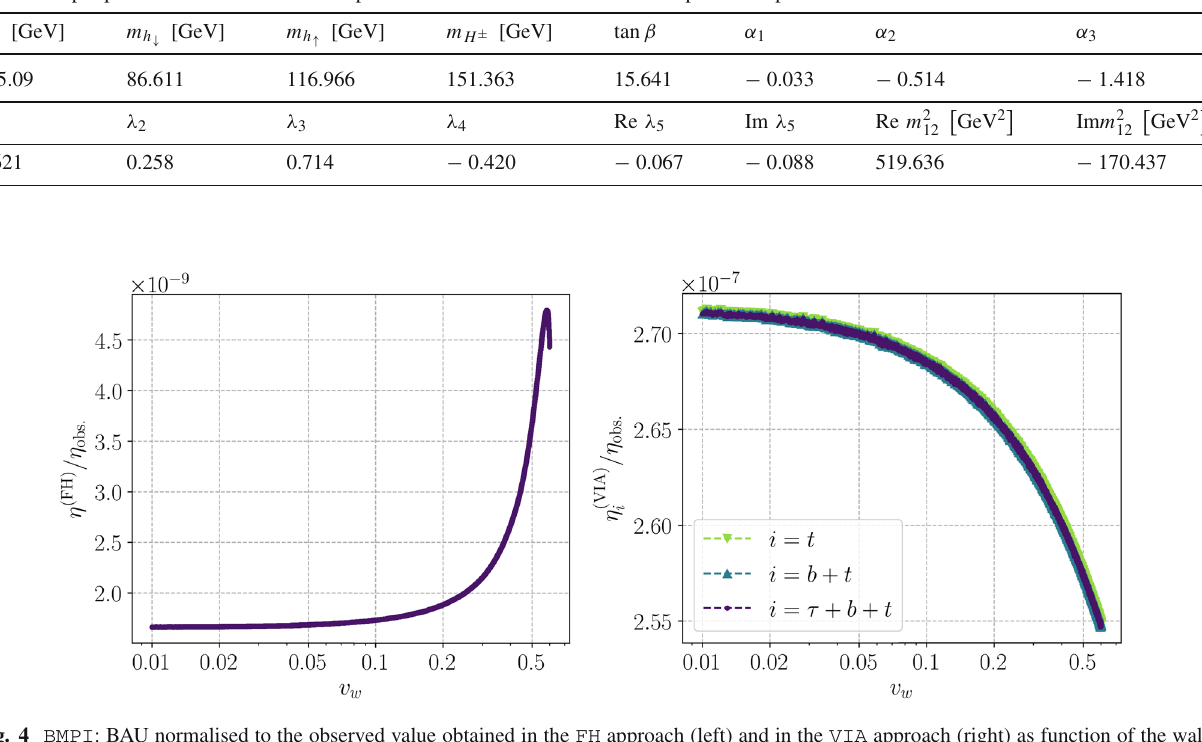
the VIA approach we show results for the case where the massive t , b and τ contributions are taken into account in the transport equations (violet points), where only t and b are included (blue triangles), and with t contributions solely (green